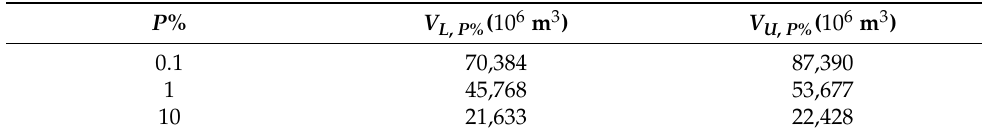
Table 3. Flood volumes above Q thr 2 at Turnu-M ă gurele gauge station.